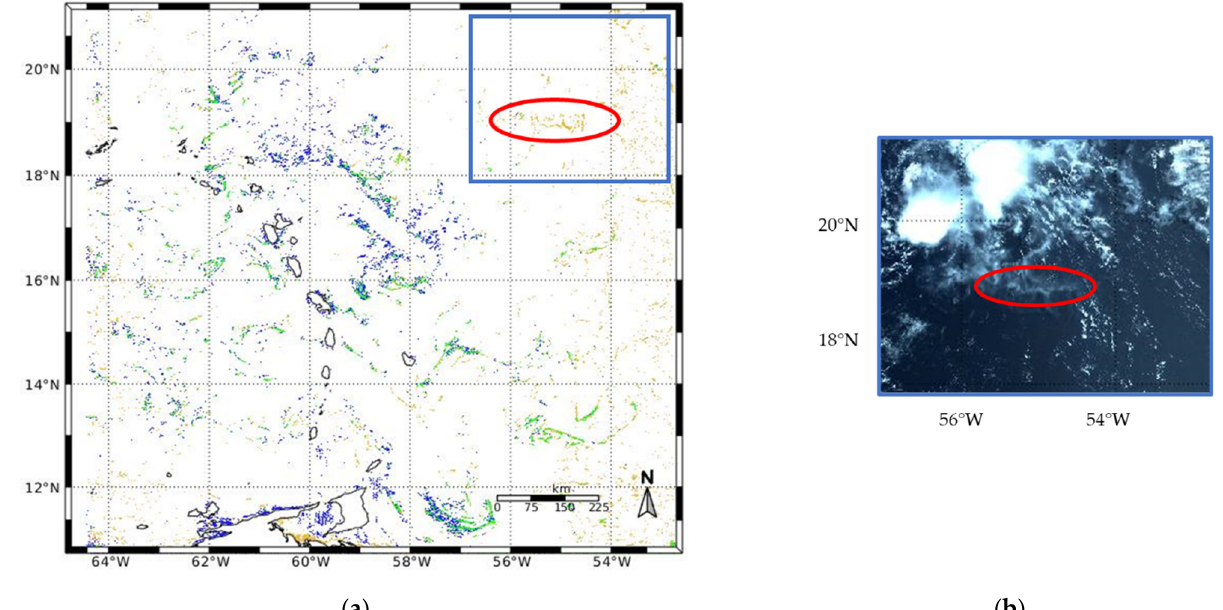
Figure 13. ( a ) Spatial distribution of the Sargassum detections for the OLCI scene acquired on 8 July 2017, using the FC values retrieved by the neural network approach (blue), by the δ MCI approach (yellow) and by both approaches (green); ( b ) RBG composite image of a regional area in the north-east corner of the OLCI scene.